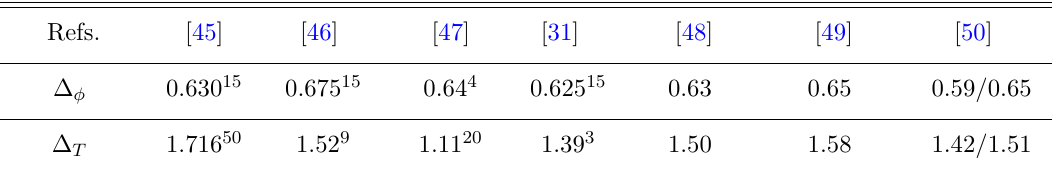
Table 1 . CFT data of SO(5) DQCP ( = est. err. ) estimated from lattice simulations or 1 /N f expansions.